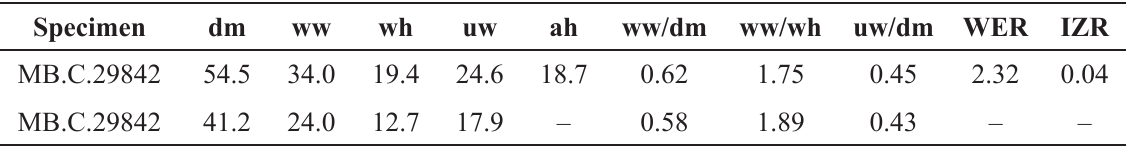
Table 14. Conch dimensions (partly estimated) and ratios of Paratirolites coronatus Korn & Ghaderi in Korn et al. (2016) from Baghuk